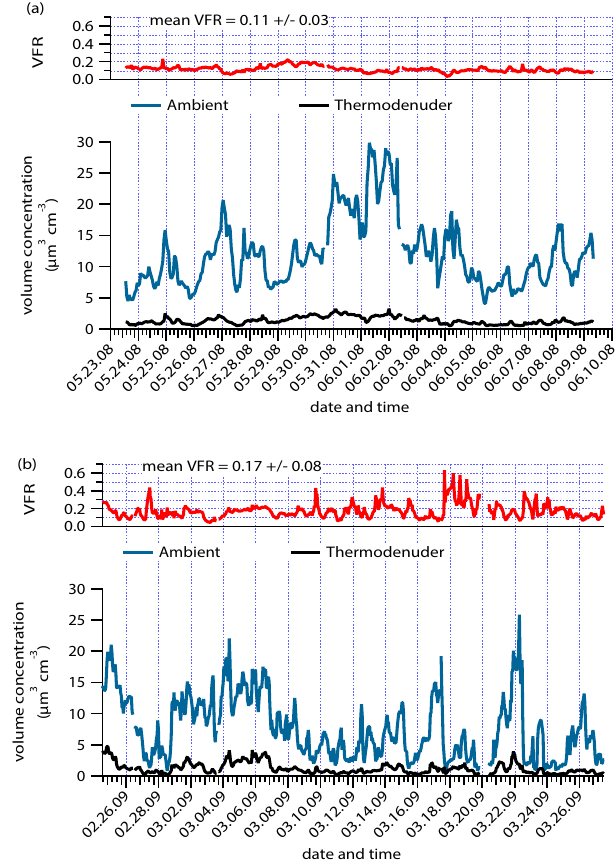
Figure 2. Time series of the ambient and non-volatile volume concentration measured during May–June 2008 (a) and February– March 2009 (b) periods. The volume fraction remaining (VFR) for each time period is also presented on the top panel of each plot, including the mean value ( ± 1 σ ) for each measurement